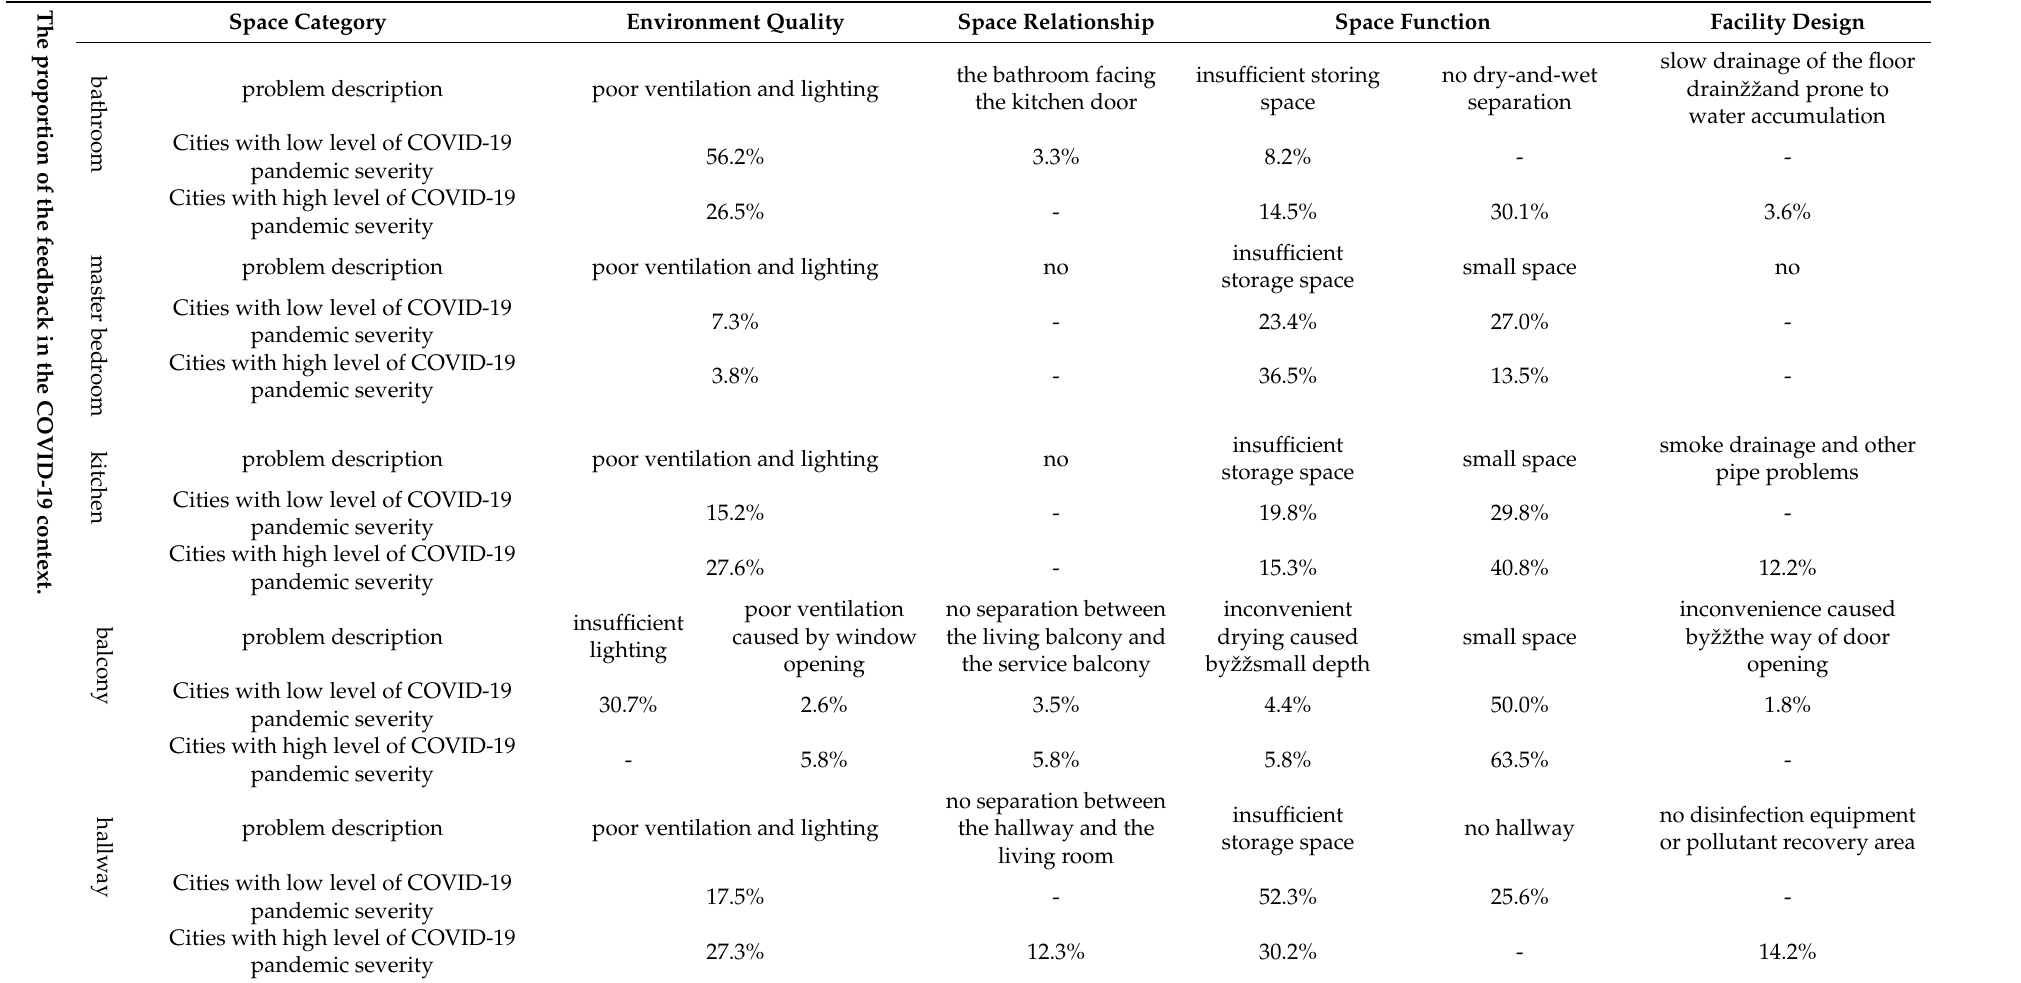
Table 4. The proportion of the entries in the context of